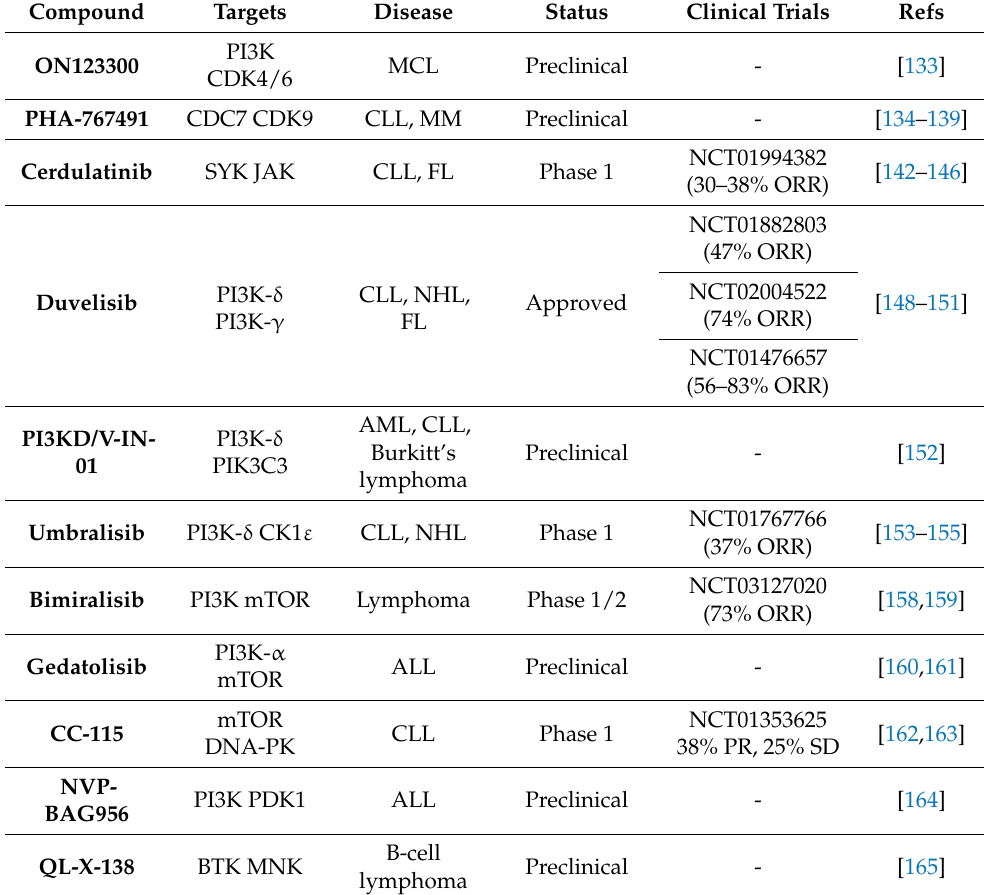
Table 2. Molecular targets and clinical studies of dual agents proposed for the treatment of lymphoid